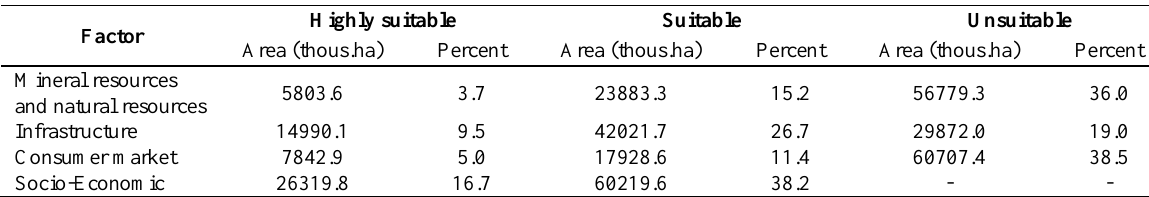
Table 5. Suitability classification result of factors